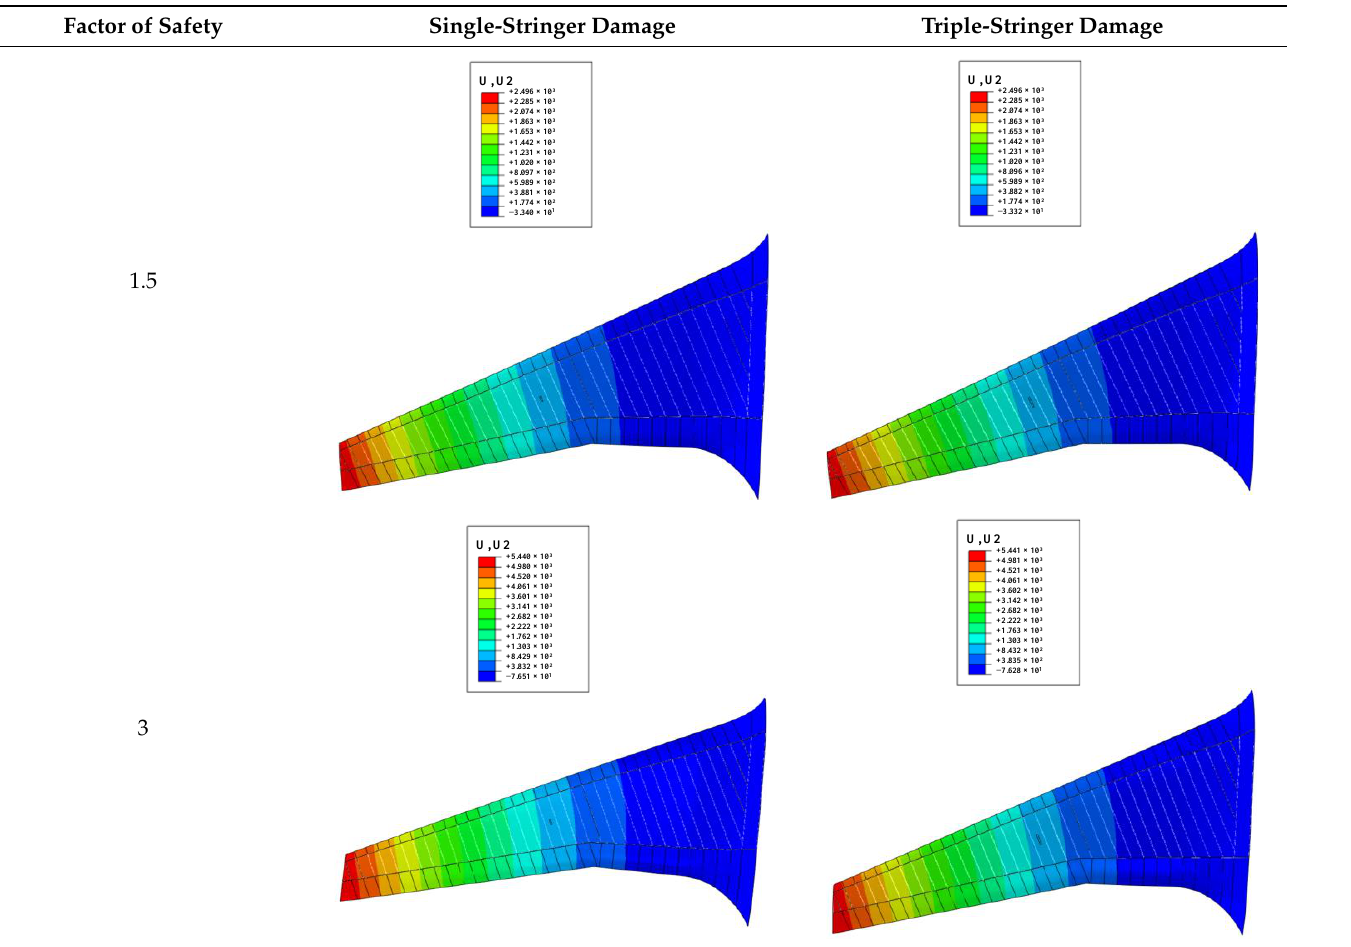
Table 5. Results of out-of-plane displacement of single-stringer and triple-stringer damage BWB wings at different values of F.o.S.